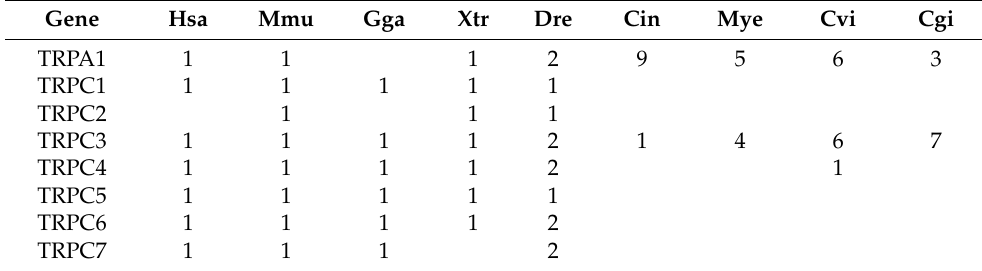
Table 1. Copy Numbers of TRP Genes in C. gigas and Other Representative Species. Information of TRP Genes from Several Other Representative Vertebrate and Invertebrate Species Were Retrieved from NCBI Database (Assembly: cgigas_uk_roslin_v1, with accession of GCA_902806645.1). Ab- breviations: Hsa, Homo sapiens ; Mmu, Mus musculus , Gga, Gallus gallus ; Xtr, Xenopus tropicalis ; Dre, Danio rerio ; Cin, Ciona intestinalis ; Mye, Mizuhopecten yessoensis ; Cvi, Crassostrea virginica ; and Cgi, Crassostrea gigas